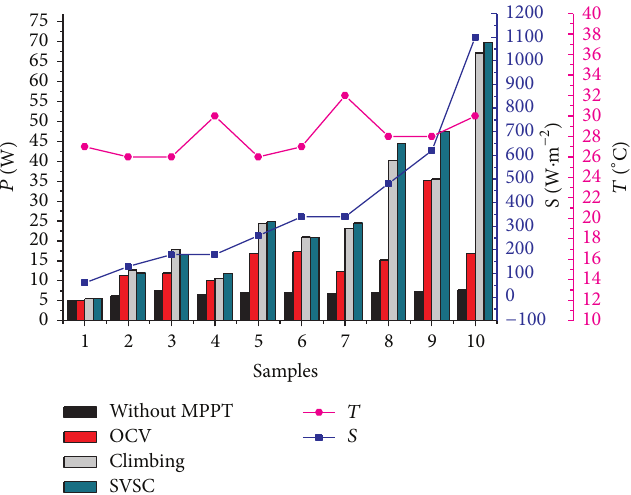
Figure 14: Input power of battery with different methods under different weather conditions.